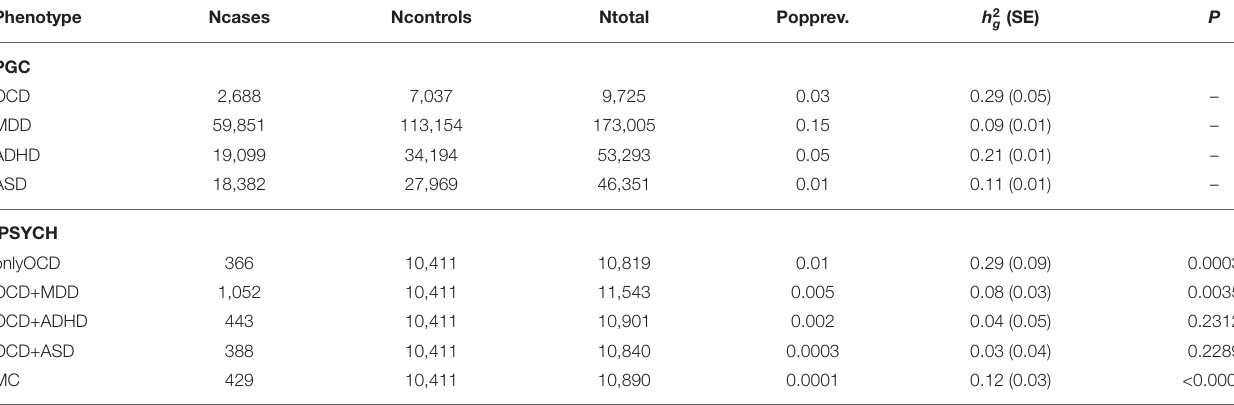
TABLE 1 | PGC and iPSYCH sample sizes, population prevalences and heritability estimates ( h 2 g